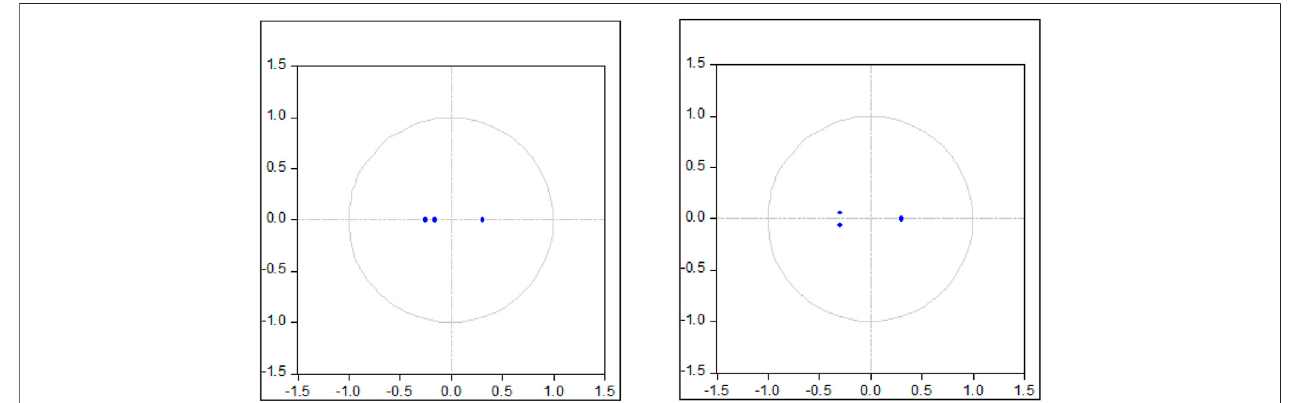
FIGURE 3 | Inverse roots of AR characteristic polynomial: US dollar/UK pound and US dollar/Euro.